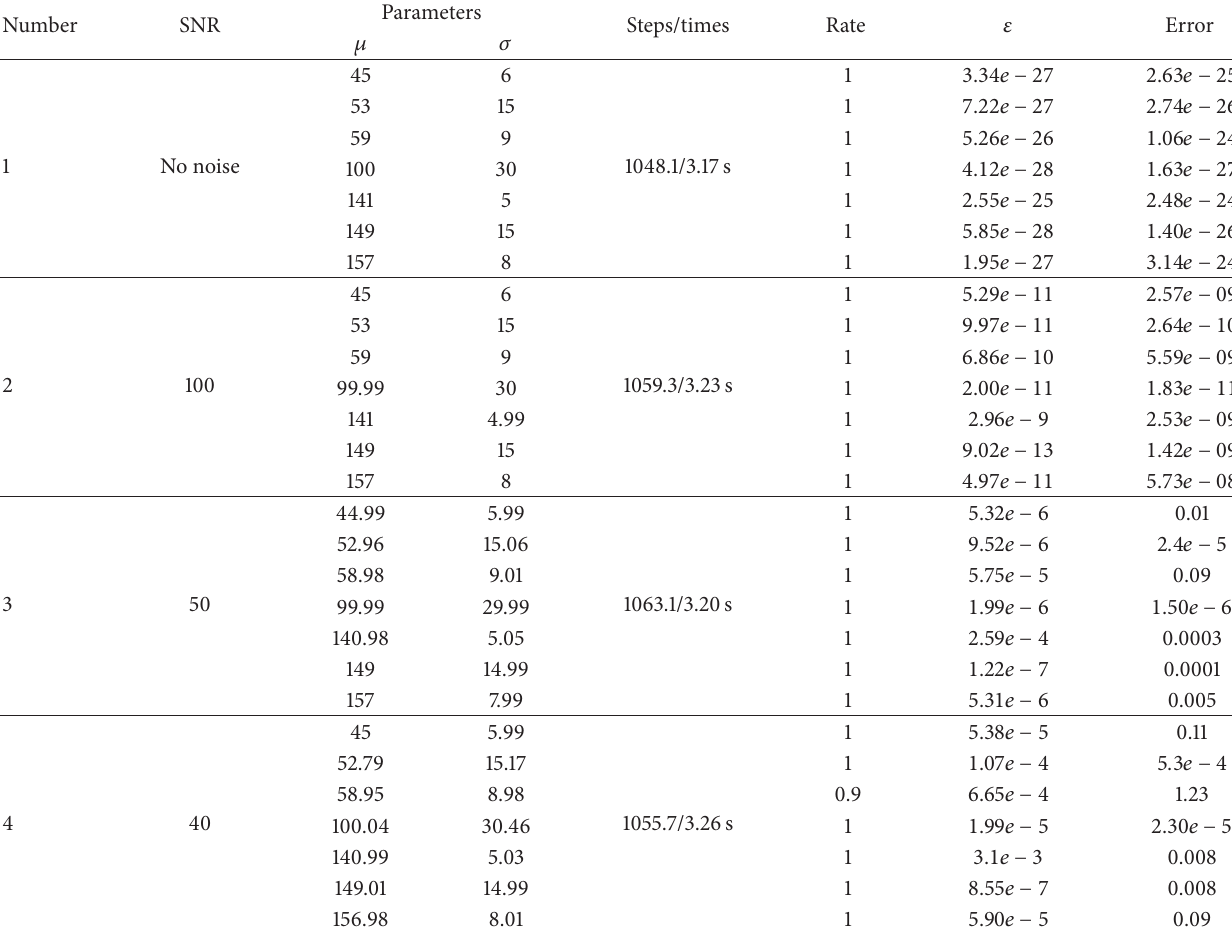
Table 1: The calculated results for the simulations with different level of white noise. The column of “Rate” indicates the rate for this parameter emerging among the total ten candidates. The column of “Error” represents the error between simulated spectra and calculated spectra.